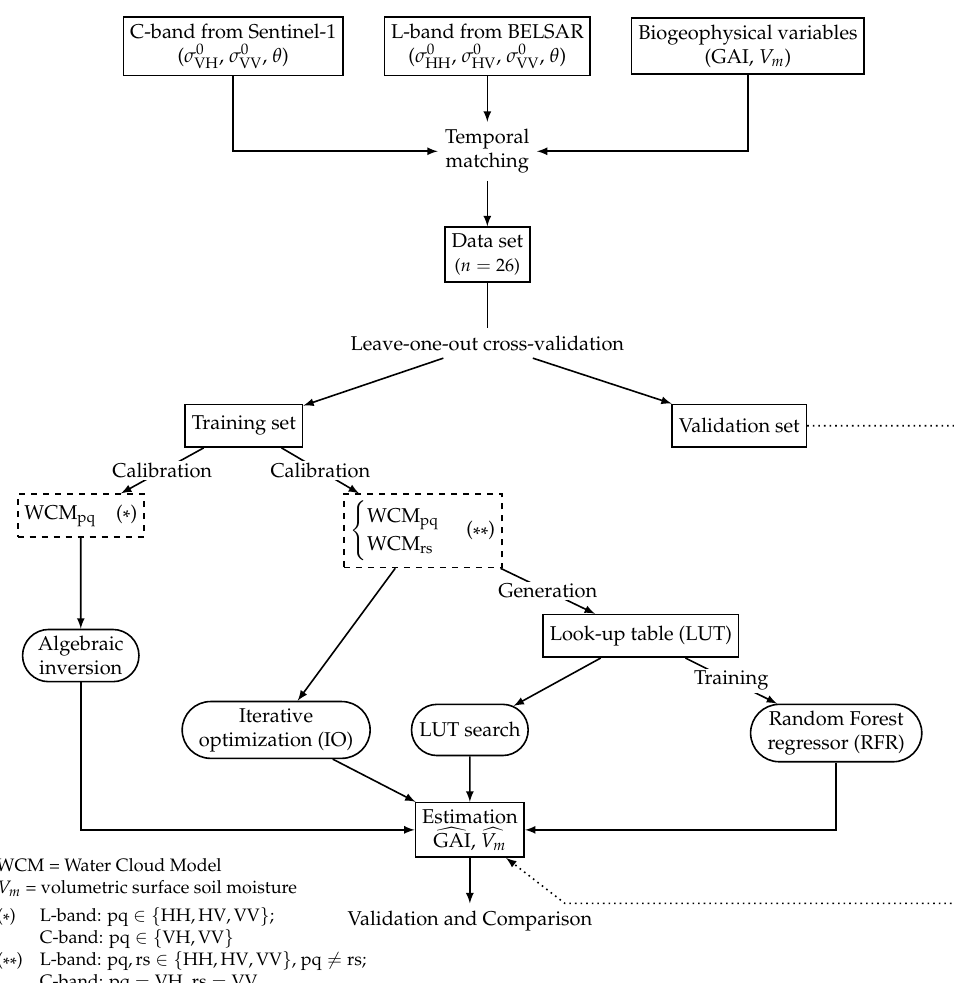
Figure 5. Flowchart of the experimental